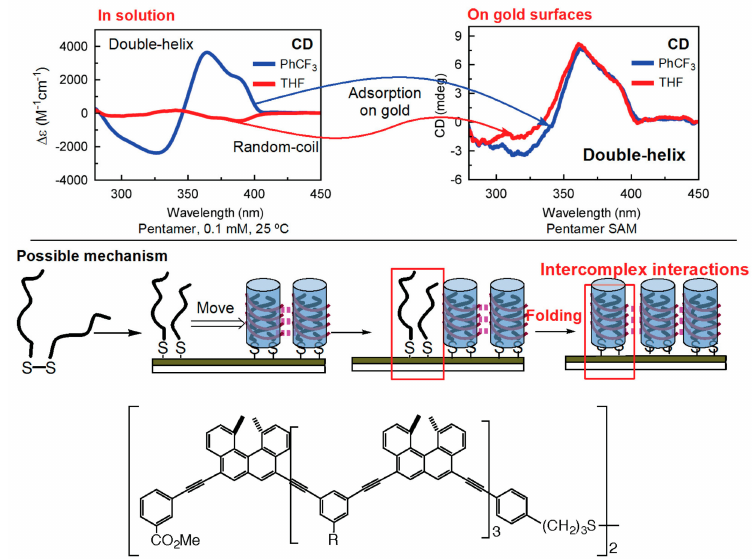
Figure 28. Formation of self-assembled monolayer (SAM) of double-helix ( P )-pentamer disulfide on a gold surfaces. Chemical structure of the ( P )-pentamer disulfide is also